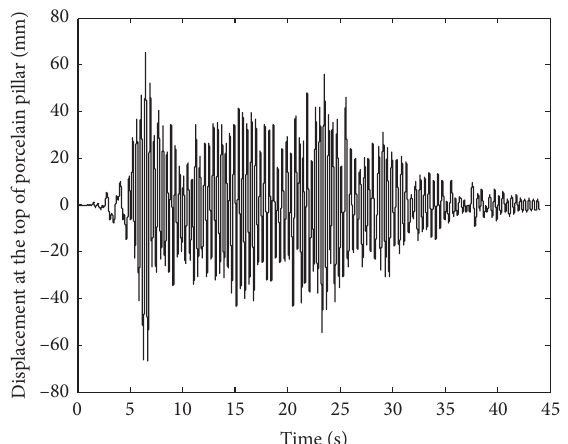
Figure 16: Displacement at the top of porcelain pillar ( a � 0.3g, η � 0).